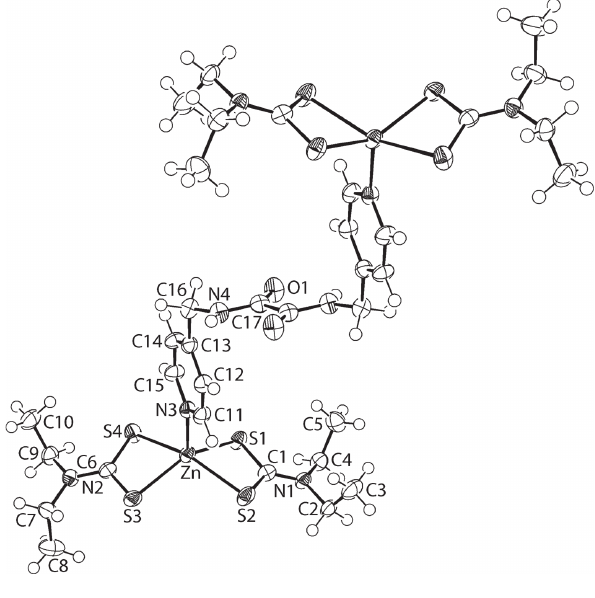
Table 1: Data collection and handling.